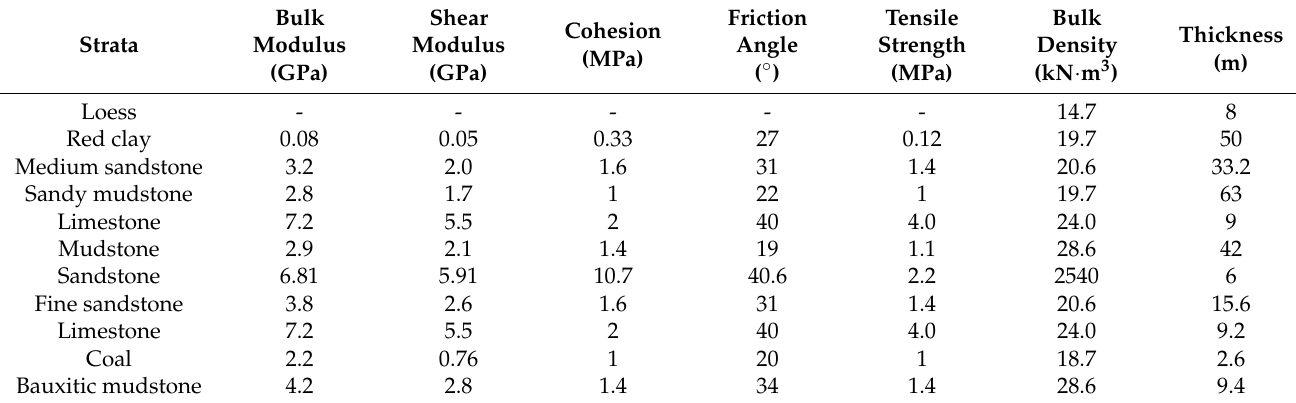
Table 3. The mechanical parameters of strata and coal seam of the numerical model.